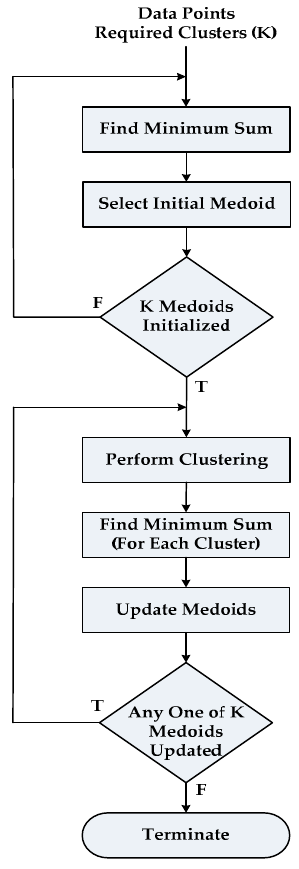
Figure 1. Flow chart of the sequential PAM algorithm.